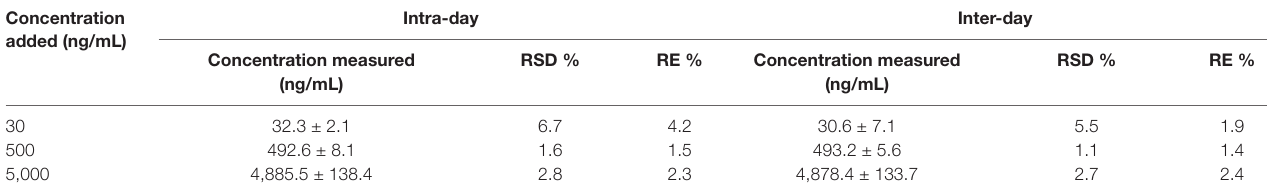
TABLE 2 | Precision and accuracy of mogroside V in rat plasma (n = 6). Concentration added (ng/mL)